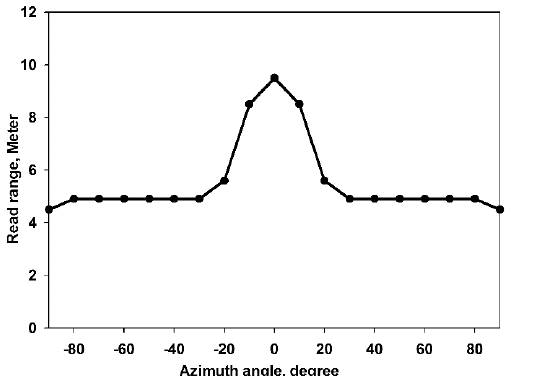
Figure 6b: Measured variations of reading range versus Azimuth angle with θ =0 o for the RFID tag at 866 MHz